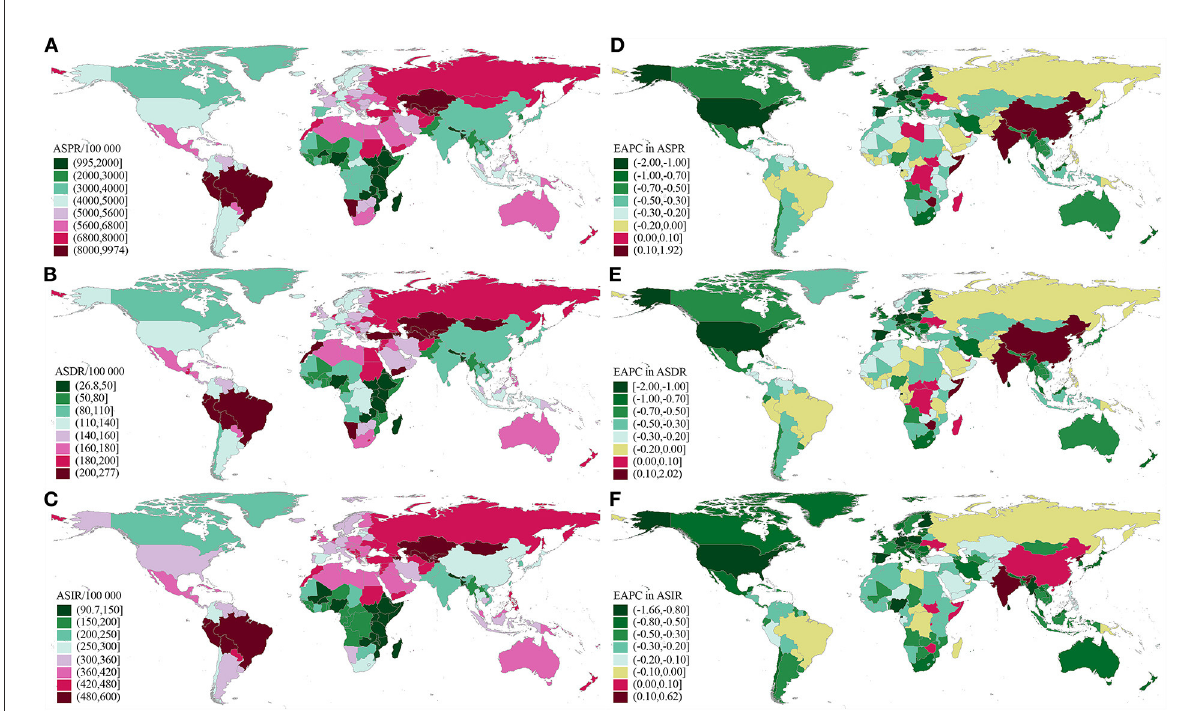
FIGURE2 Global distribution of ASRs and the corresponding EAPCs in edentulism. (A) ASPR in 2019; (B) ASDR in 2019; (C) ASIR in 2019; (D) EAPC of ASPR from 1990 to 2019; (E) EAPC of ASDR from 1990 to 2019; (F) EAPC of ASIR from 1990 to 2019. ASRs, age-standardized rates; EAPC, estimated annual percentage change; ASPR, age-standardized prevalence rate; ASDR, age-standardized DALY rate; DALYs, disability-adjusted life years; ASIR, age-standardized incidence